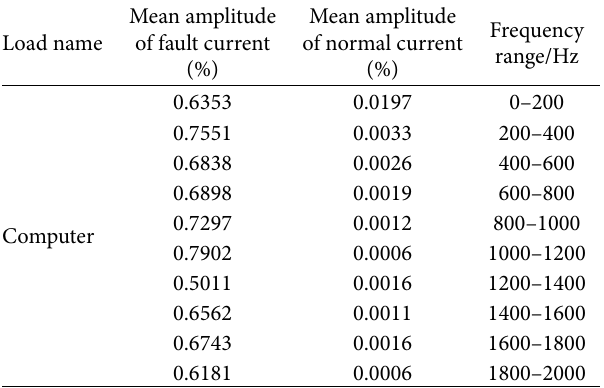
Table 6: Frequency domain feature values of hand drill load circuit. Load